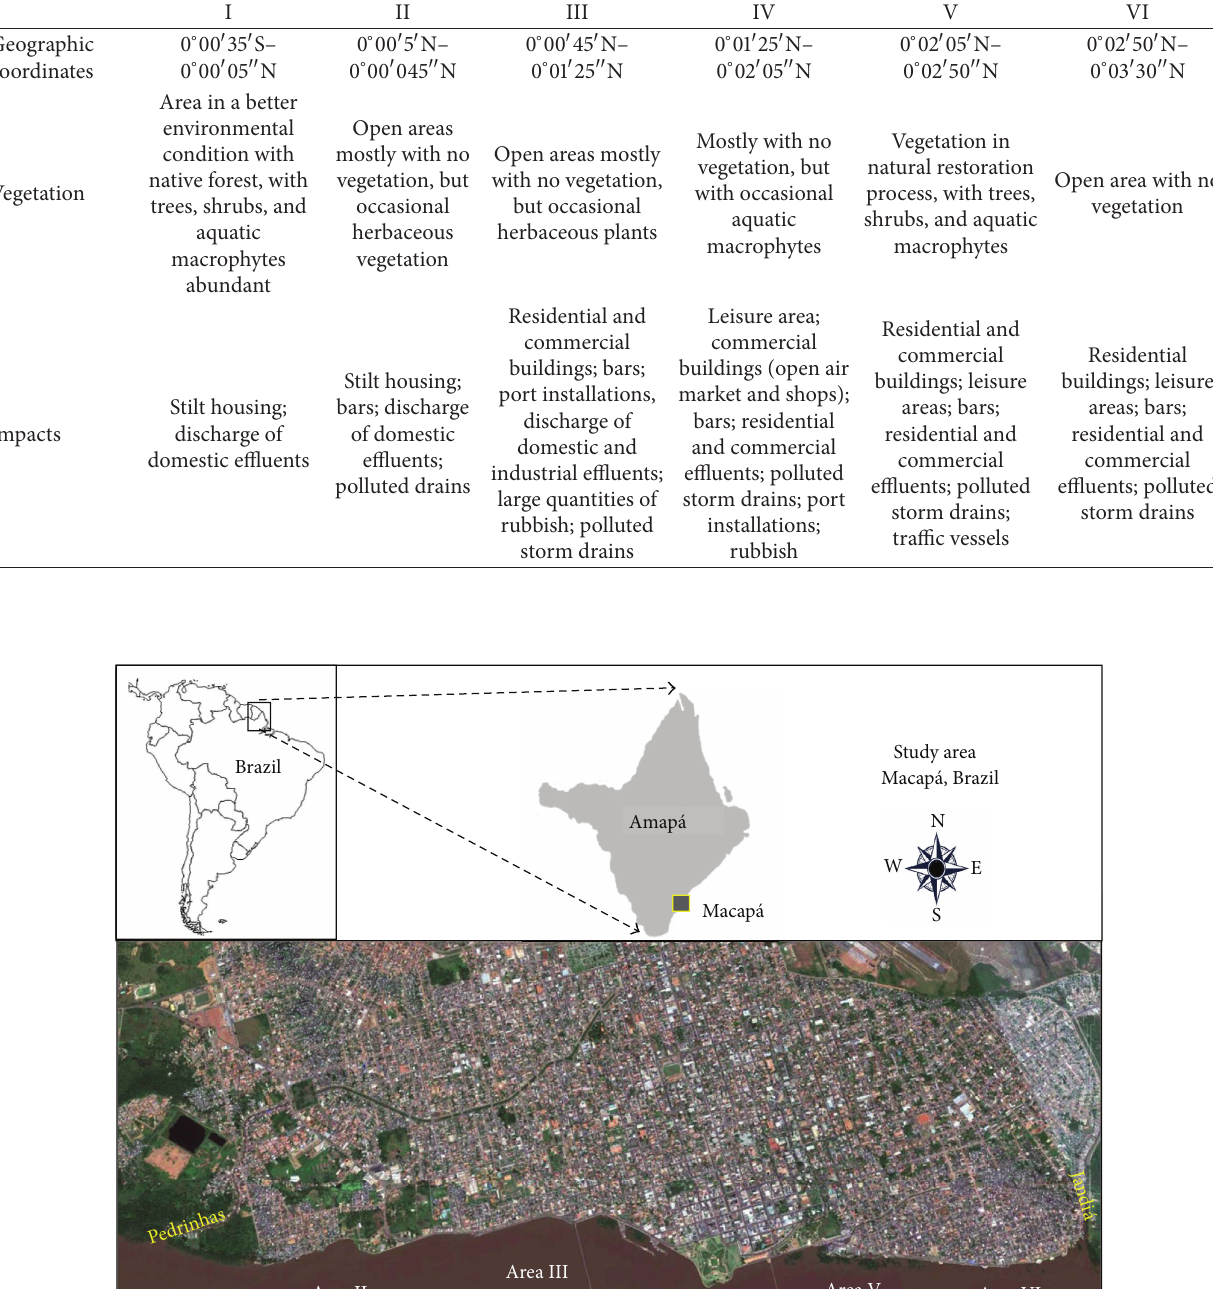
Table 1: Characteristics of the study sectors surveyed on the waterfront of Macap´a, in the Brazilian state of Amap´a. Variable Geographic